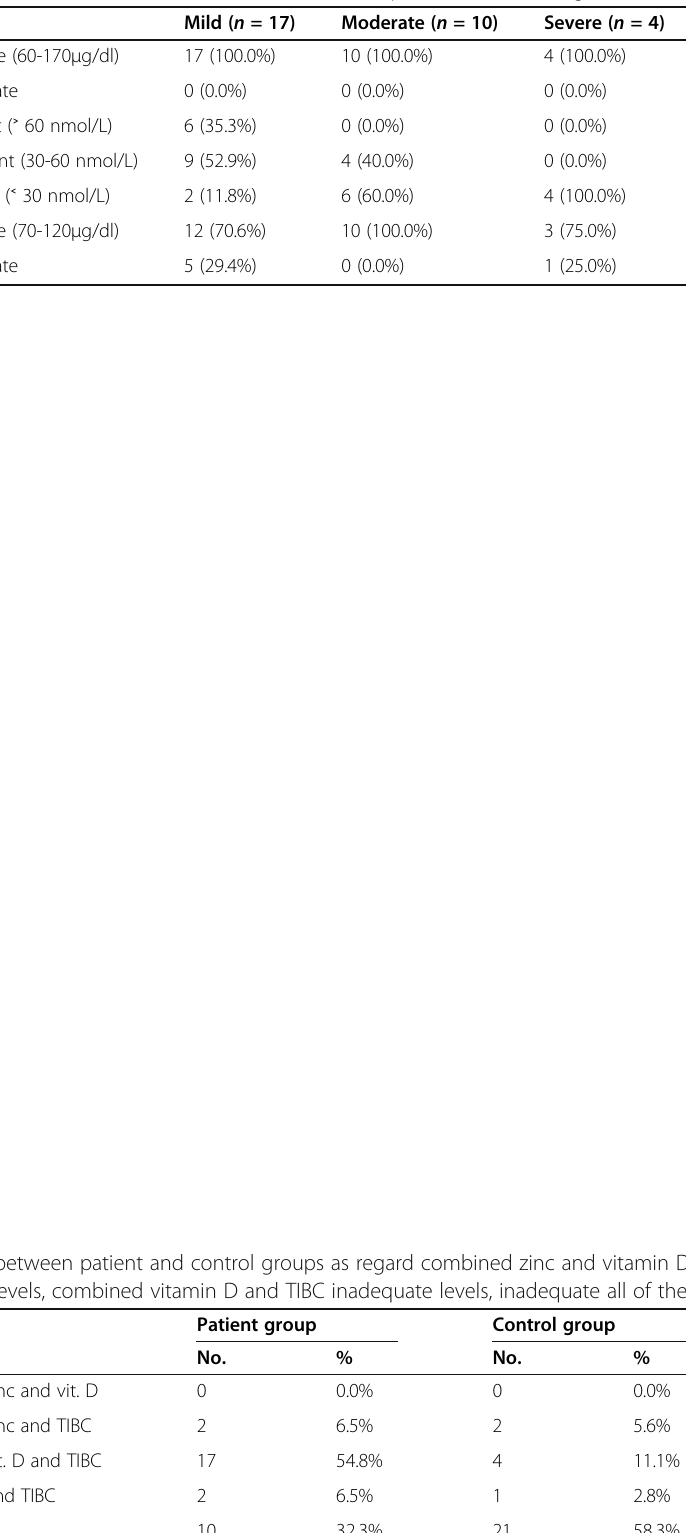
Table 7 Serum iron, serum vitamin D, and serum zinc levels compared to normal range in different severity of pneumonia